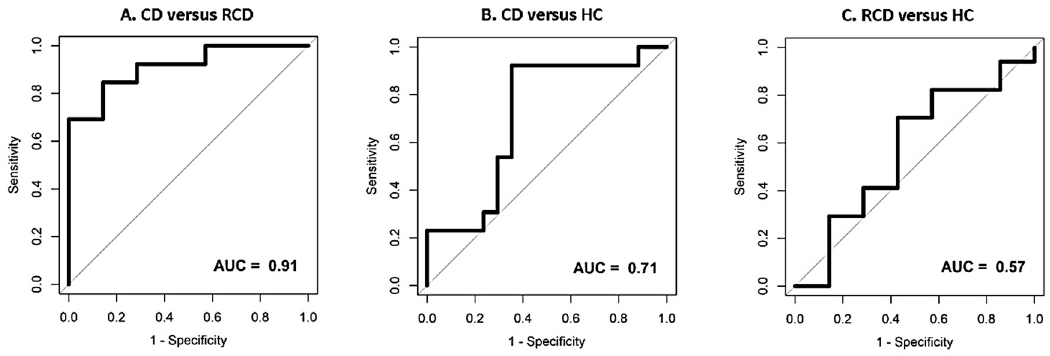
Figure 2. Receiver operator characteristic (ROC) curves for the differentiation between coeliac disease, refractory coeliac disease and healthy controls using faecal volatile organic compounds. ( A ) Coeliac disease versus refractory coeliac disease; ( B ) coeliac disease versus healthy controls; ( C ) refractory coeliac disease versus healthy controls. Figures are generated using the support vector machine based on the 100 most discriminatory features. Abbreviations: AUC, area under the curve; CD, coeliac disease; RCD, refractory coeliac disease; HC, healthy controls.